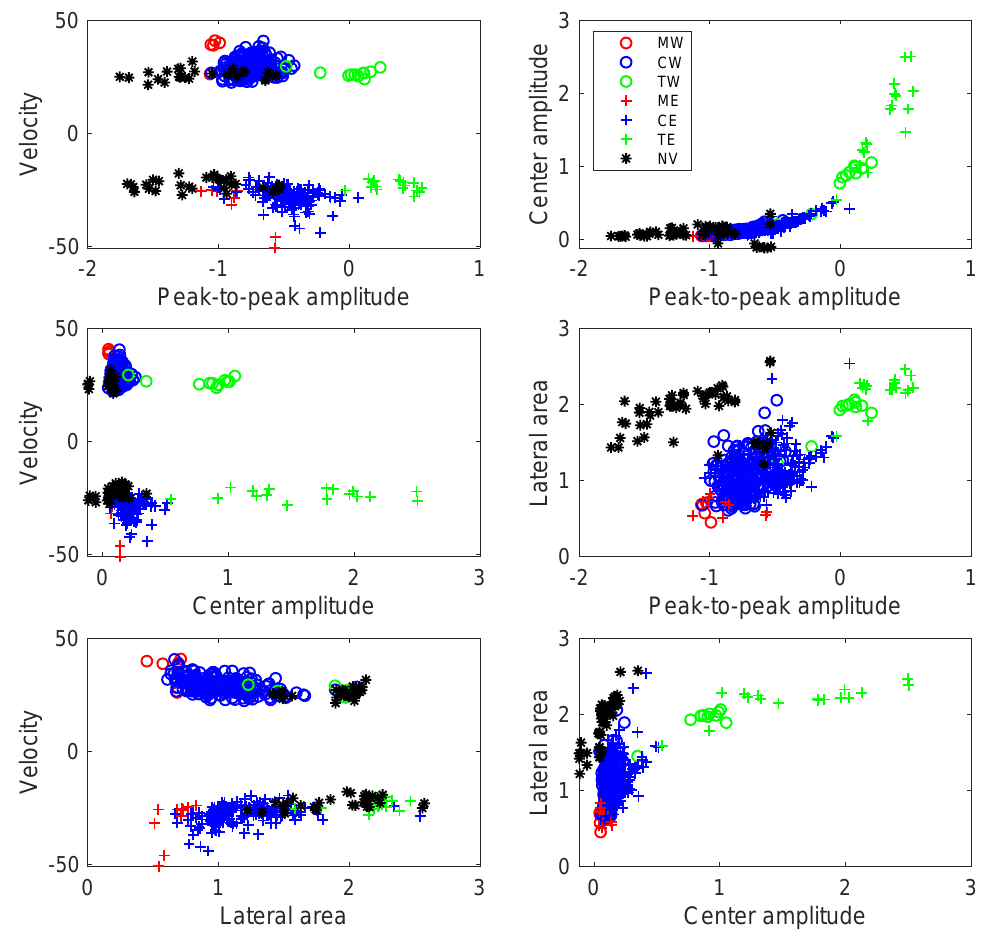
Figure 9. Two-dimensional scatter plot projections of the four-dimensional feature space showing the feature vectors of the seven classes: MW (red circles), CW (blue circles), TW (green circles), ME (red crosses), CE (blue crosses), TE (green crosses), and NV (black asterisks). The plots correspond to the feature combinations: peak-to-peak amplitude vs. velocity; center amplitude vs. velocity; lateral area vs. velocity; peak-to-peak amplitude vs. center amplitude; peak-to-peak amplitude vs. lateral area; and center amplitude vs. lateral